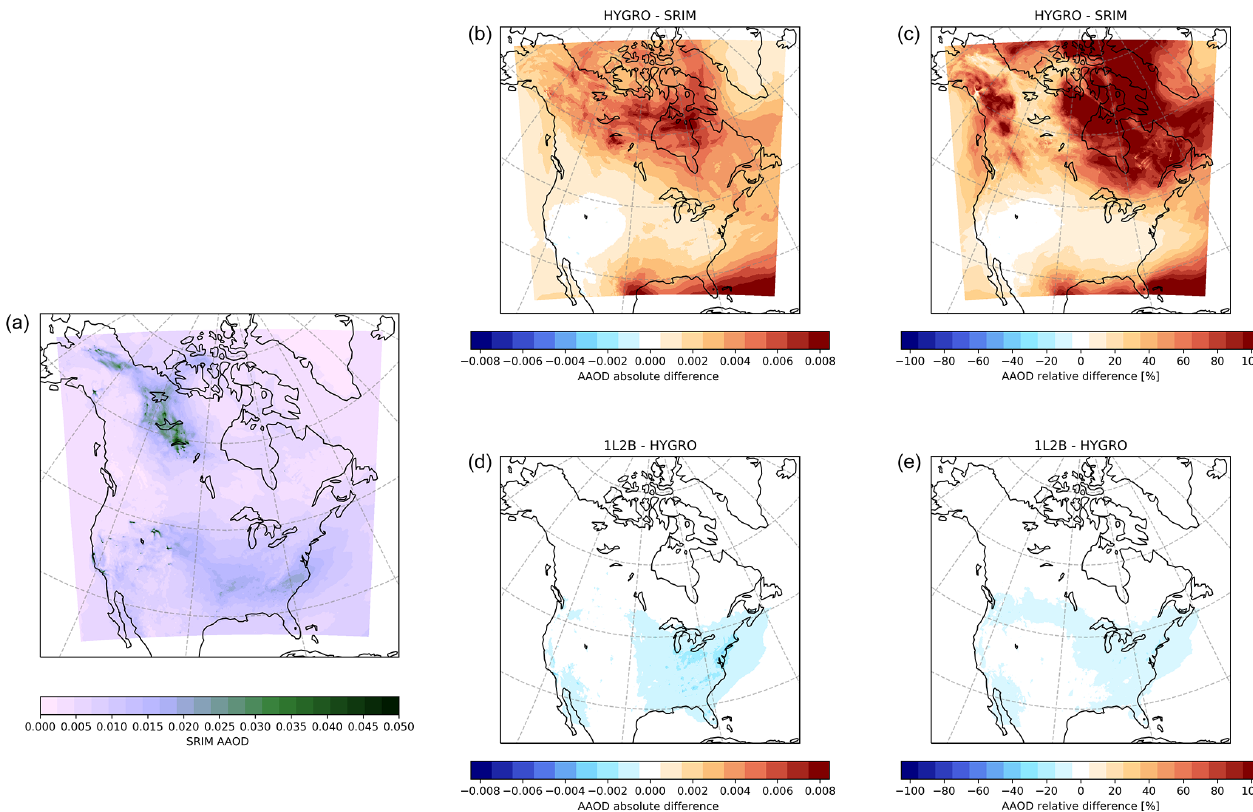
Figure 7. (a) Mean AAOD from the SRIM simulation, (b) mean difference in AAOD between the HYGRO and SRIM simulations, (c) rela- tive difference in mean AAOD between the HYGRO and SRIM simulations, (d) mean difference in AAOD between the 1L2B and HYGRO simulations, and (e) relative difference in mean AAOD between the 1L2B and HYGRO simulations. Only results from the hours of 13:00– 21:00UTC are included as the AOD is only calculated during local daylight